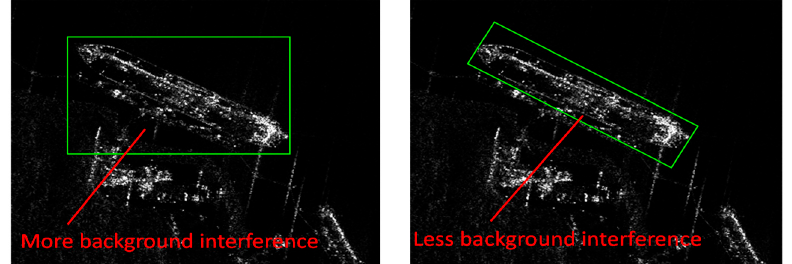
Figure 1. Comparison of horizontal bounding box and rotated bounding box. The left picture shows that horizontal bounding box contains more background interference, while rotated bounding box contains less.